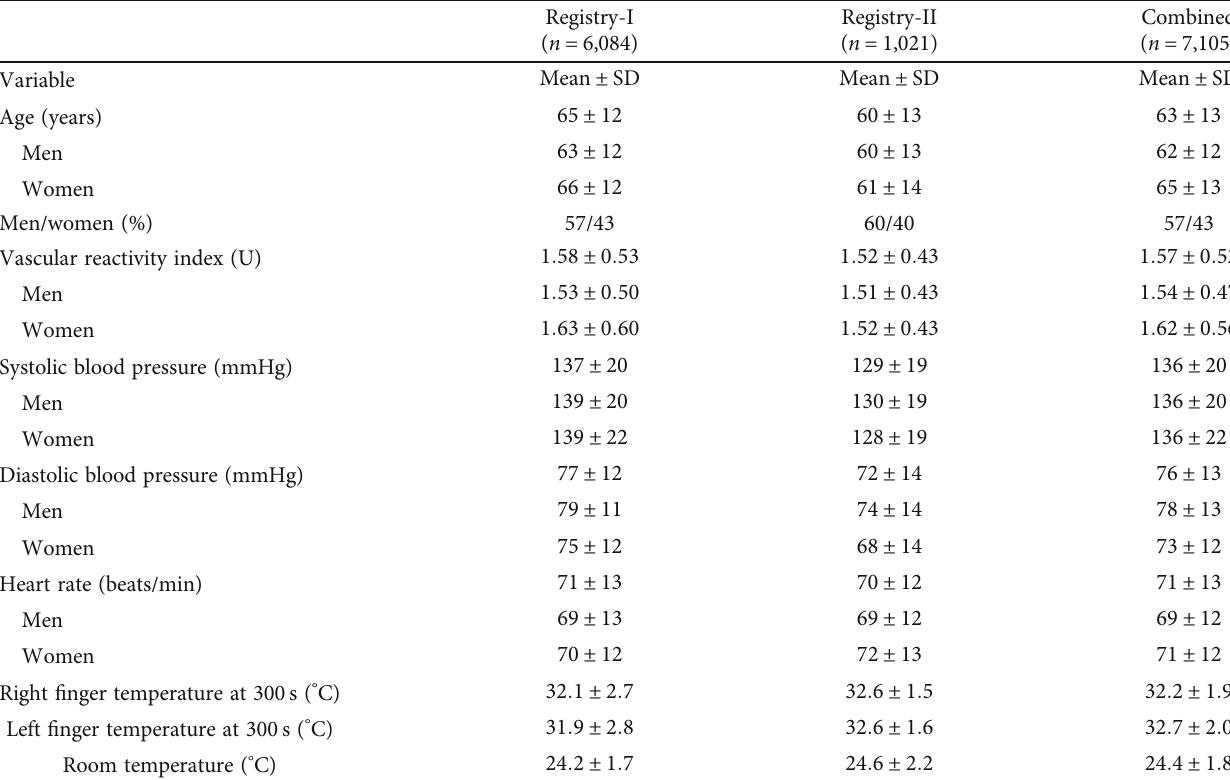
Figure 2: Sample test for digital thermal monitoring (DTM) of vascular reactivity. A sample screen displays the right fi nger temperature curve (red), the left fi nger temperature curve (blue), and the zero reactivity curve (green). The vascular reactivity index (VRI) is taken as the adjusted maximum value of the temperature curve during the reactive hyperemic period. Zero reactivity curve (ZRC) is the green line, calculated based on predicted temperature rebound in the right fi nger if no reactive hyperemia were elicited by the 5-minute cu ff occlusion. Table 1: Selected patient and test